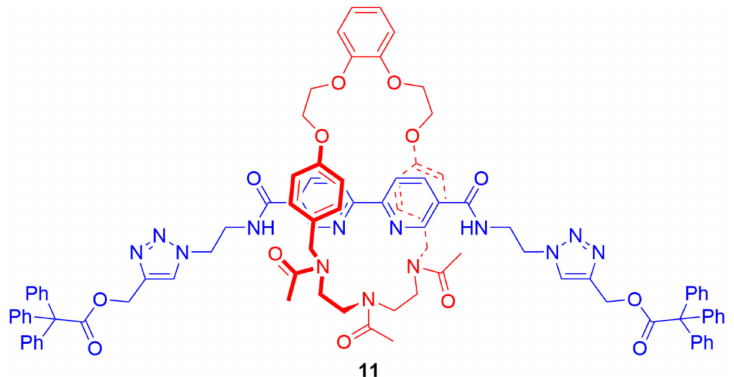
Figure 9. Ghosh’s tris-acylated rotaxane 11 lockable using alkali metal cations.